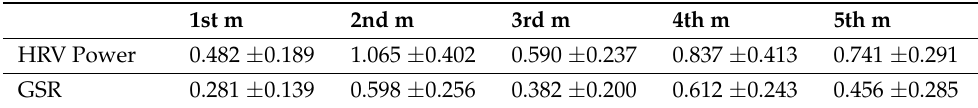
Figure 14. Experiment 3 Box plot for Growth rate of HRV power and GSR. In addition, the mean value for the growth rate of HRV and the GSR (i.e., Table 9) raises due to the increase in situational challenges. Table 9. Mean and standard deviation of experiment 3.